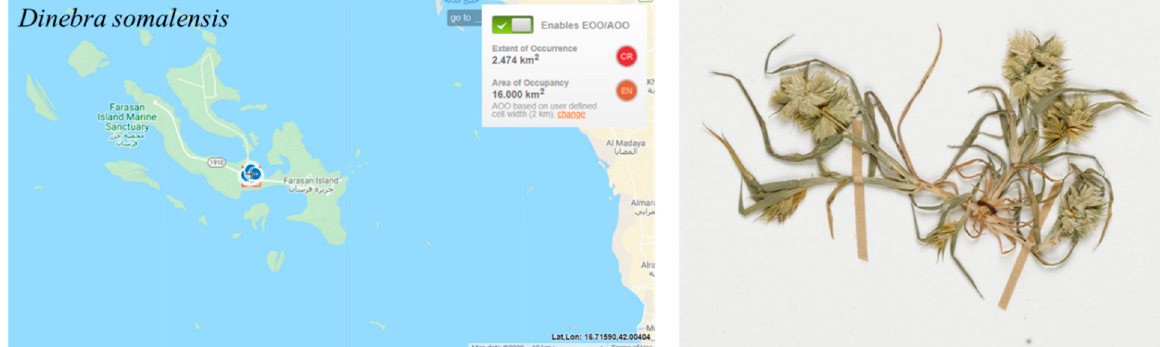
Figure 10. Geographical distribution of Dinebra somalensis in the Farasan Archipelago. Plant photo reproduced from RBGE herbarium catalogue https://data.rbge.org.uk/search/herbarium/ accessed on 1 June 2019. ( I.S. Collenette-5009 from Farasan Islands).